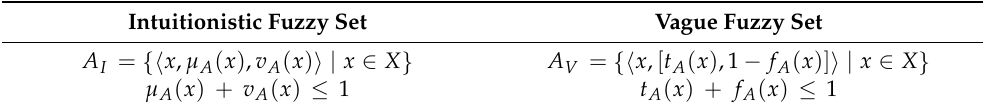
Table 3. Definition of the intuitionistic fuzzy set and the vague fuzzy